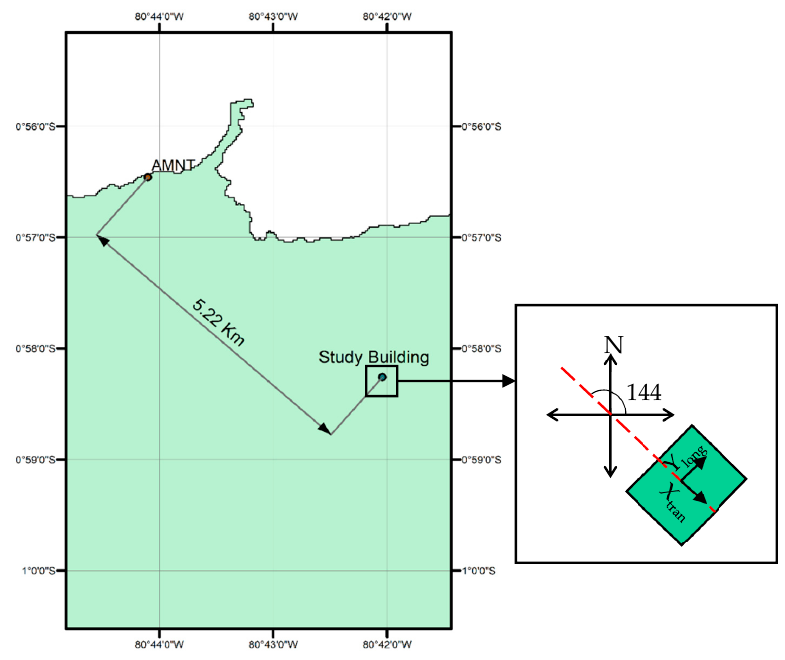
Figure 14. Location and distance between the studied building and the closest accelerometric station, AMNT. The orientation of the building with respect to north is also depicted.